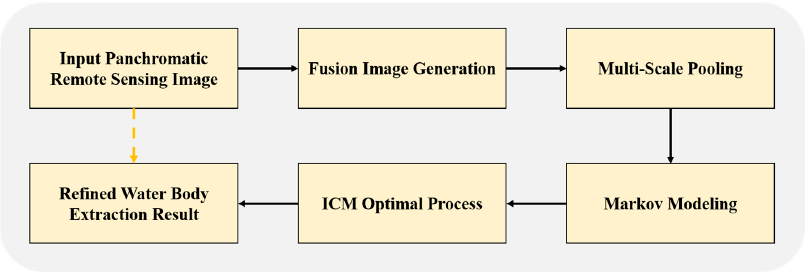
Figure 2. The refined water body extraction workflow of our proposed method.